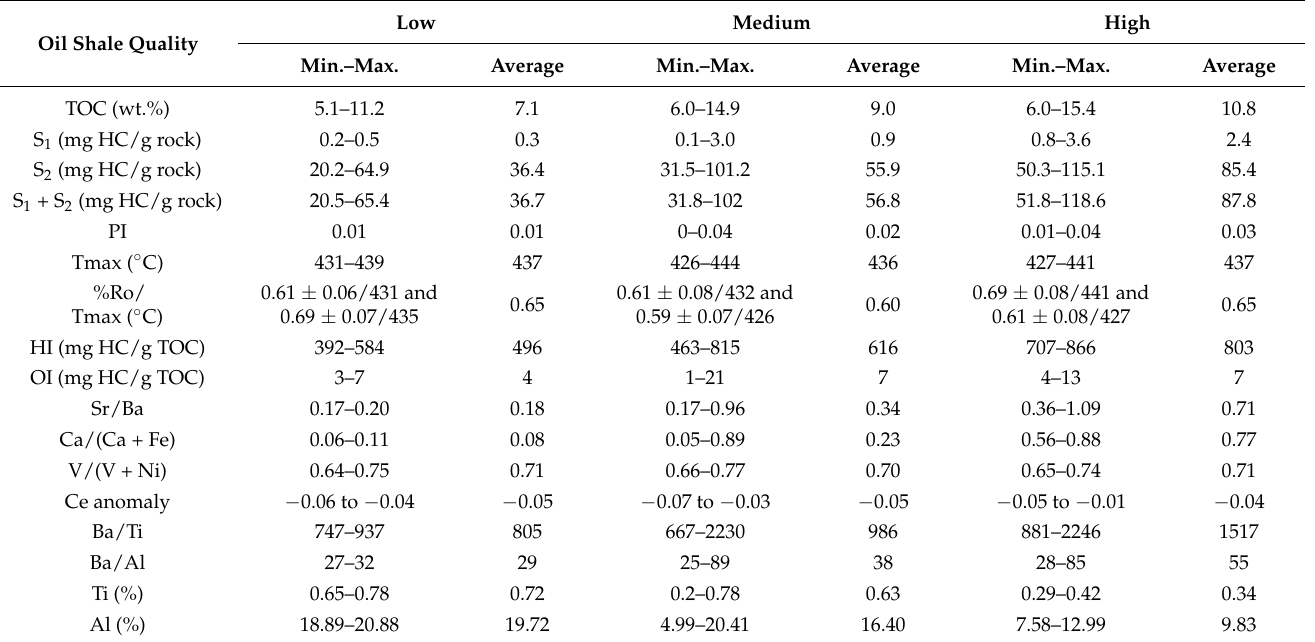
Table 3. Minimum, maximum, and average values of total organic carbon (TOC), Rock-Eval param- eters, and element ratios of different quality oil shales in the Shale Member of the Middle Jurassic Shimengou Formation, Yuqia area, Qaidam Basin.